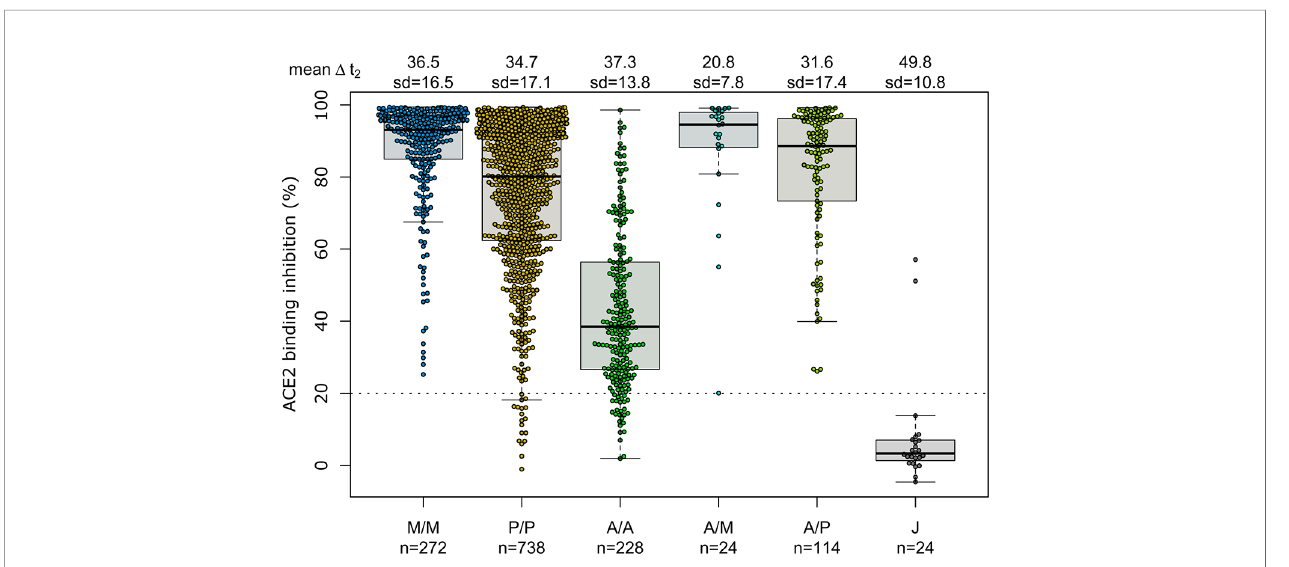
FIGURE 3 | Different vaccination schemes impact ACE2 binding inhibition against SARS-CoV-2 wild-type. ACE2 binding inhibition against the SARS-CoV-2 wild- type (B.1 isolate) RBD was assessed by an ACE2-RBD competition assay for homologous mRNA [mRNA-1273 (M/M, blue), BNT162b2 (P/P, orange)], heterologous prime-boost (AZD1222-mRNA-1273 (A/M, light blue), AZD1222-BNT162b2 (A/P, light green) or vector-based [AZD1222-AZD1222 (A/A, green), Ad26.CoV2.S (J, grey)] vaccination schemes in the mix and match cohort. Data is shown as box and whisker plots overlaid with strip charts. Boxes represent medians, 25th and 75th percentiles and whiskers show the largest and smallest non-outlier values based on 1.5 IQR calculation. The threshold for non-responsive samples (ACE2 binding inhibition less than 20%) is shown as dotted line. All samples below this threshold can be considered non-responsive. Time between sampling and full vaccination is displayed as mean and SD for each group. Number of samples per vaccination scheme are stated below. ACE2 binding inhibition towards VoCs can be found in Supplementary Figure 2